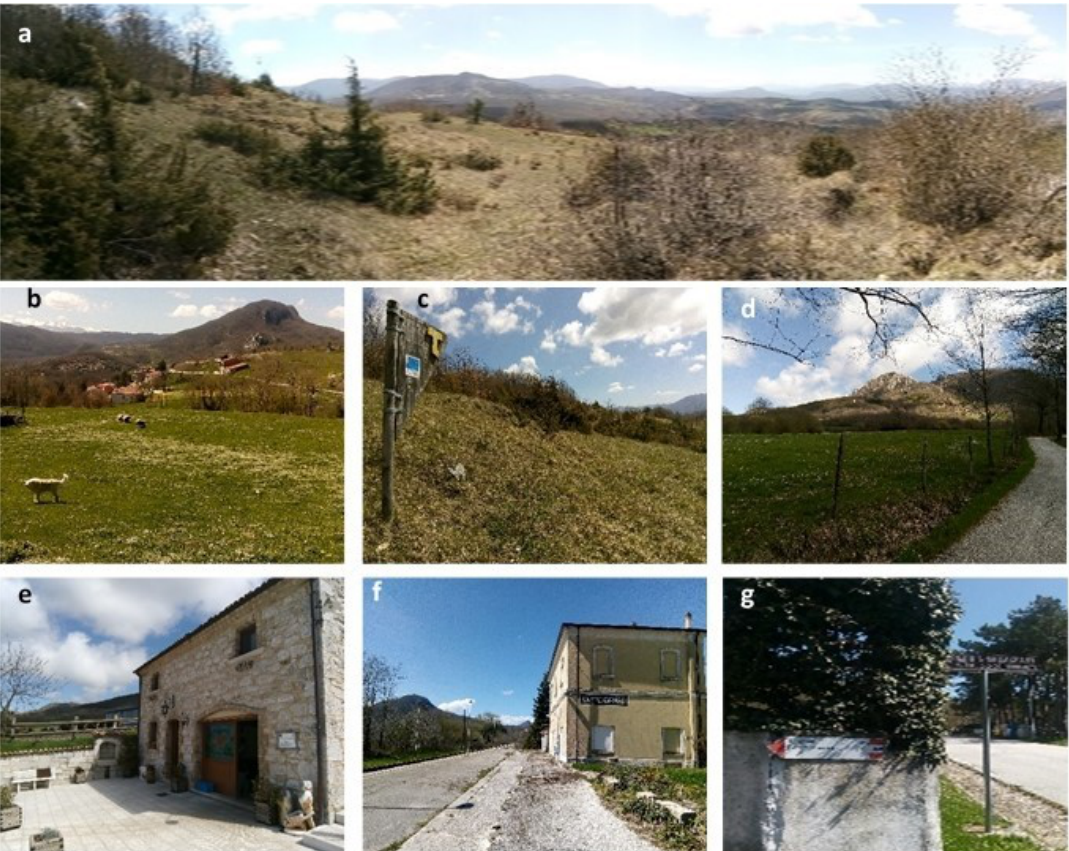
Figure 13. Landscapes and services in the pilot area: ( a ) The selected stretch of Tratturo Celano-Foggia, with the shrubs conquering the grass terrain in the foreground and the mountain ranges all around; ( b ) A few sheep grazing in the side pastures and the typical shepherd dog controlling them; ( c , d ) The chromatic contrast, due to the different index and quality of vegetation, between the drove road (the T on the wooden signal stands for Tratturo ) and the side pastures; ( e ) A small family-run dairy at the edge of the drove road and a cheese shop in a renovated building maintaining the typical stone architecture; ( f ) The small station of Vastogirardi on the Isernia-Sulmona panoramic railway line, now only used for tourism with historical trains, in the village of Cerreto, a few meters from one of the access points to the selected stretch of the drove road; ( g ) Indicators near the railway station to reach the drove road (15 min) and a bed and breakfast.